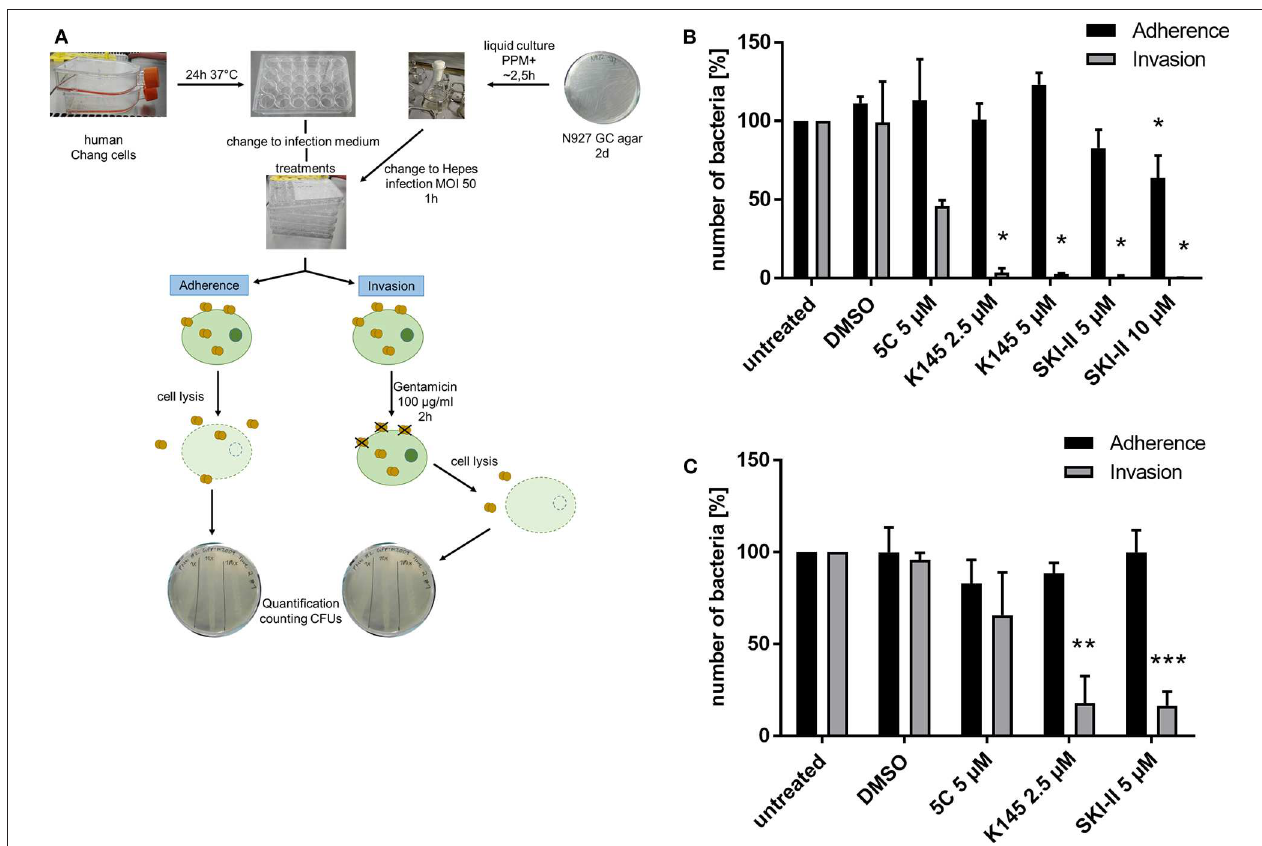
FIGURE 1 | Effects of SphKs inhibitors on intra- and extracellular Neisseria . (A) Scheme of Gentamicin protection assay with N. gonorrhoeae . (B) Effect of SphK inhibitors on the infection of Chang cells with N927. The SphK inhibitors were added to Chang cells at the indicated concentrations for 2h before infection with N927 as outlined in (A) . (C) The experiment described in (B) was repeated with End1 cells. Shown is the mean ± SD of three independent experiments. * p < 0.05, ** p < 0.001, *** p < 0.0001 student’s t -test relative to untreated